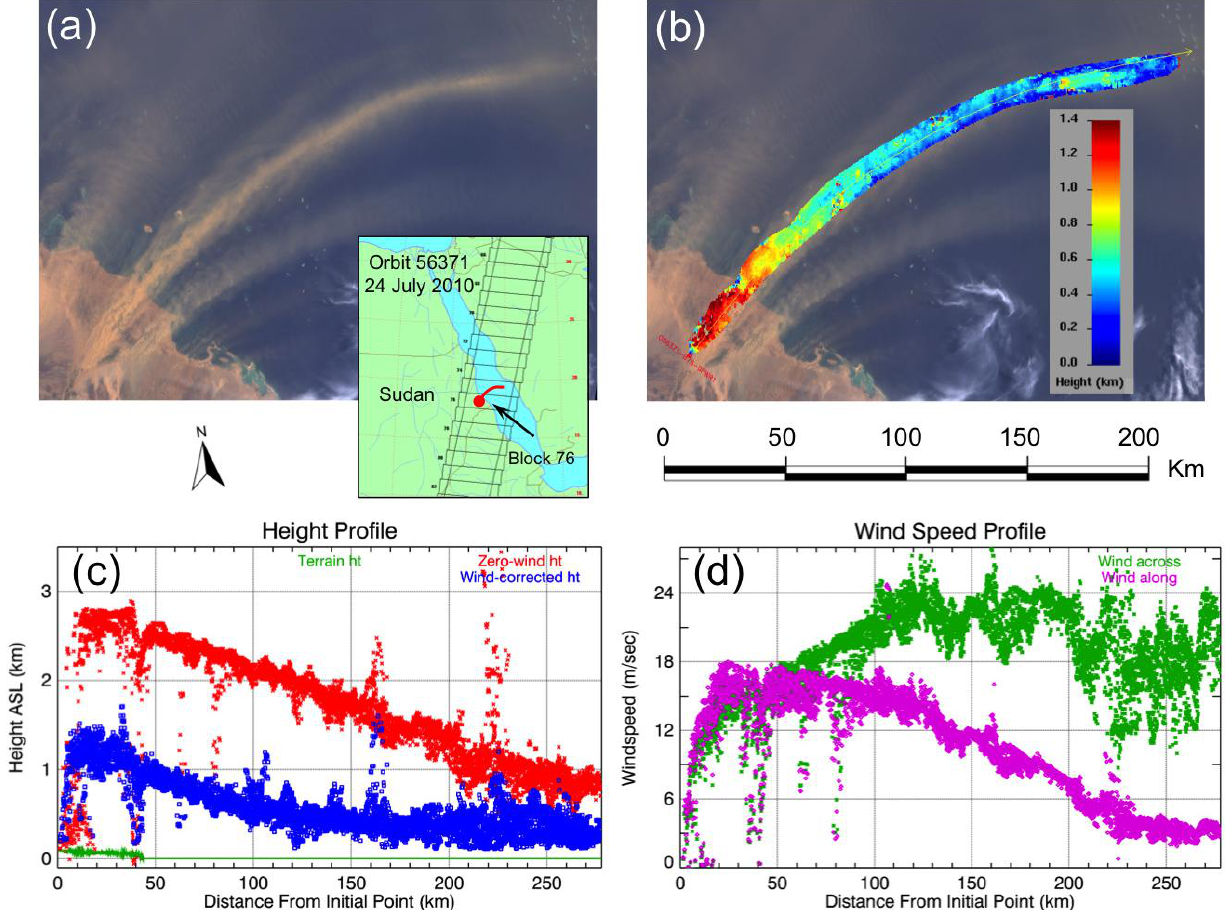
Figure 16. Dust over the Red Sea on MISR orbit 56371, block 75–76, from 24 July